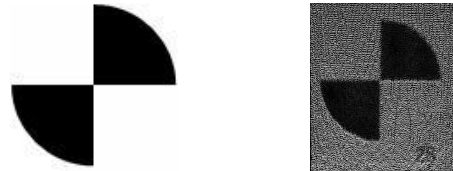
Figure 1. A typical black/white target and its point cloud